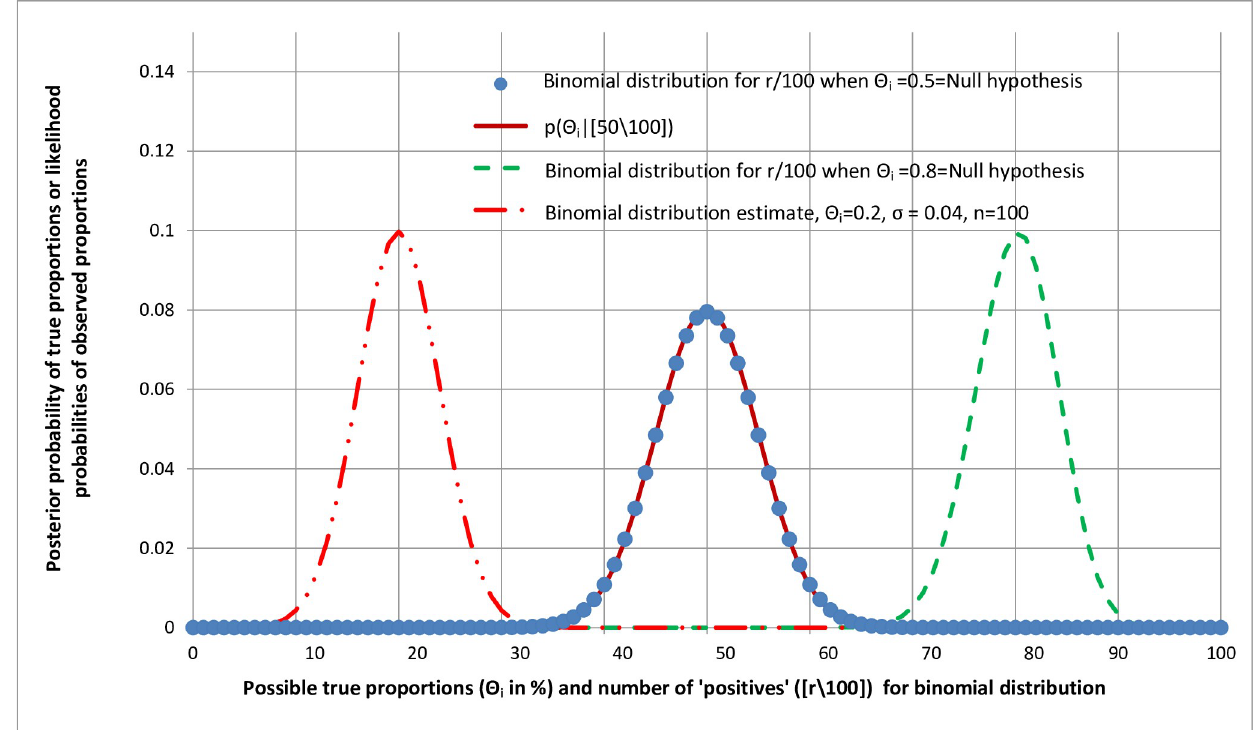
Fig 3. Comparison of distributions of posterior probabilities of true proportions conditional on observed proportions and binomial and Gaussian likelihood distributions.